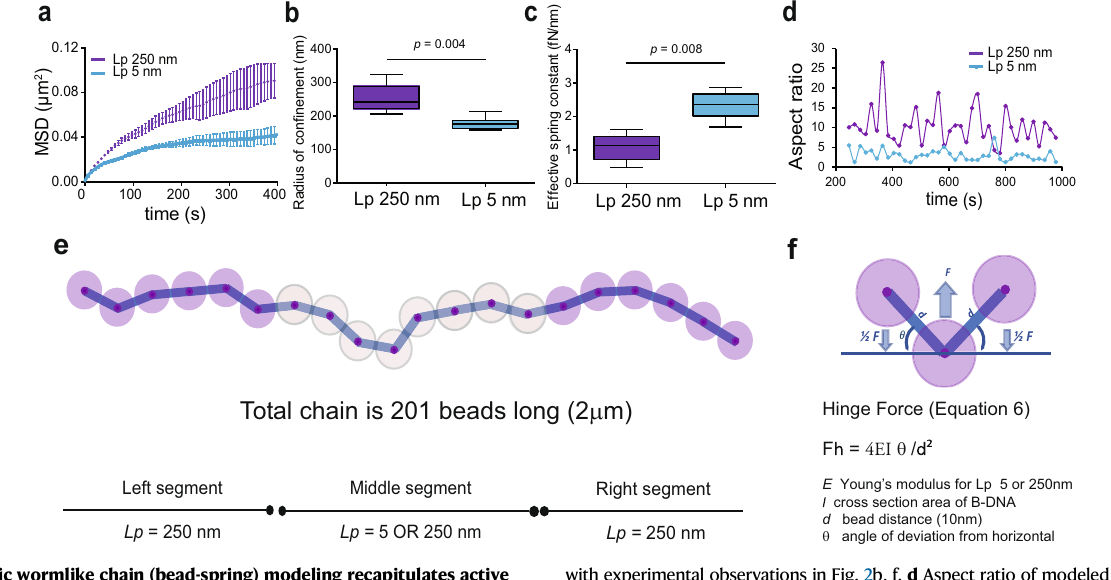
Fig. 6 | Elastic wormlike chain (bead-spring) modeling recapitulates active (Lp=5) and repressed (Lp=250) chromatin material properties. a Aggregated MSDs for 26-bead subsegment within the high persistence length (L p =250nm) segment represents repressed chromatin (purple, n =5 randomly seeded simula- tions), low persistence length (L p 5nm) segment represents active chromatin (blue, n =6 randomly seeded simulations). Data are presented as mean values+/ − SEM. DecreasingL p to 5nm reduces the radiusof con fi nement( b ) and increasesapparent effective spring constant (k s ) for the 26-bead-subsegment by 2-fold ( c ), consistent